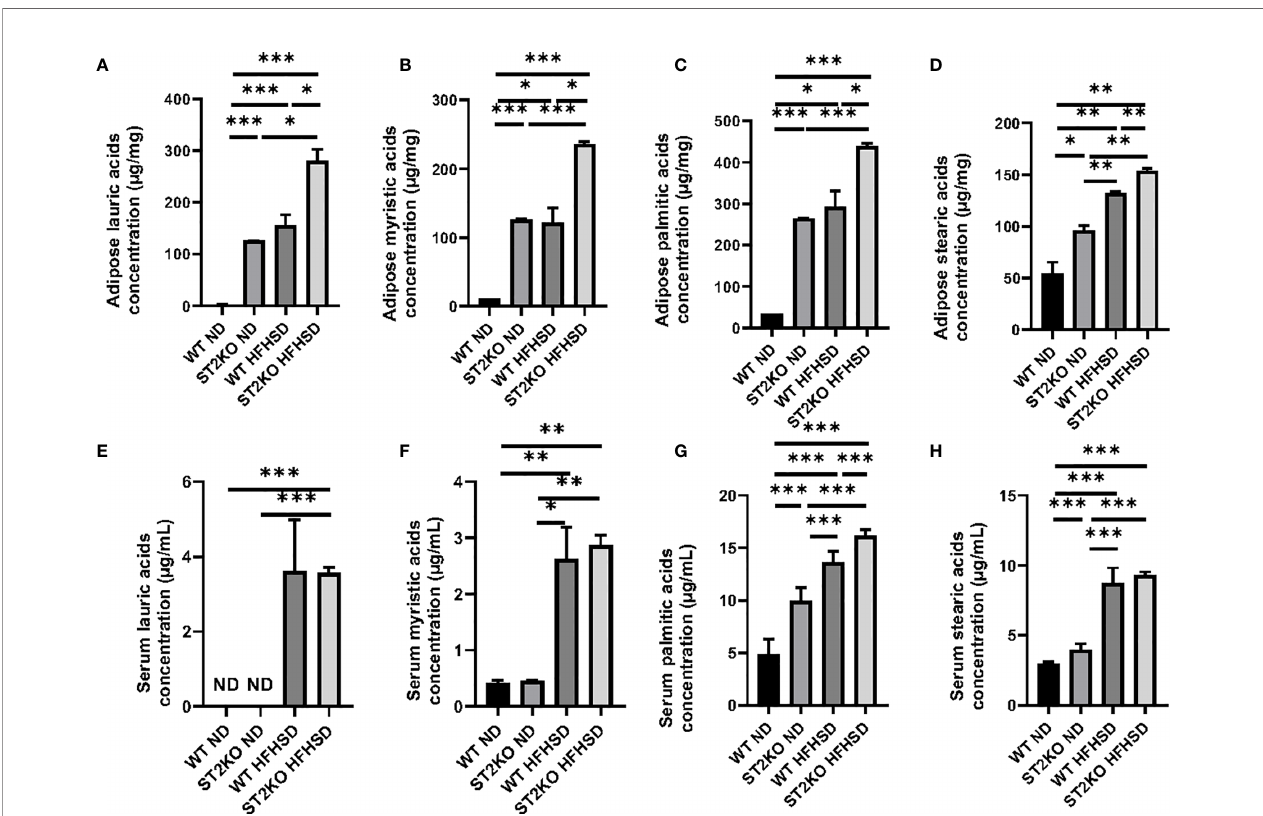
FIGURE 4 | The de fi ciency of ST2 caused increasing of saturated fatty acids. (A) Adipose lauric acid concentration (µg/mg). (B) Adipose myristic acid concentration (µg/mg). (C) Adipose palmitic acid concentration (µg/mg). (D) Adipose stearic acid concentration (µg/mg). (E) Serum lauric acid concentration (µg/ml). (F) Serum myristic acid concentration (µg/ml). (G) Serum palmitic acid concentration (µg/ml). (H) Serum stearic acid concentration (µg/ml). Data are represented as mean±SD; *p < 0.05, **p < 0.01, ***p < 0.001 by one-way ANOVA